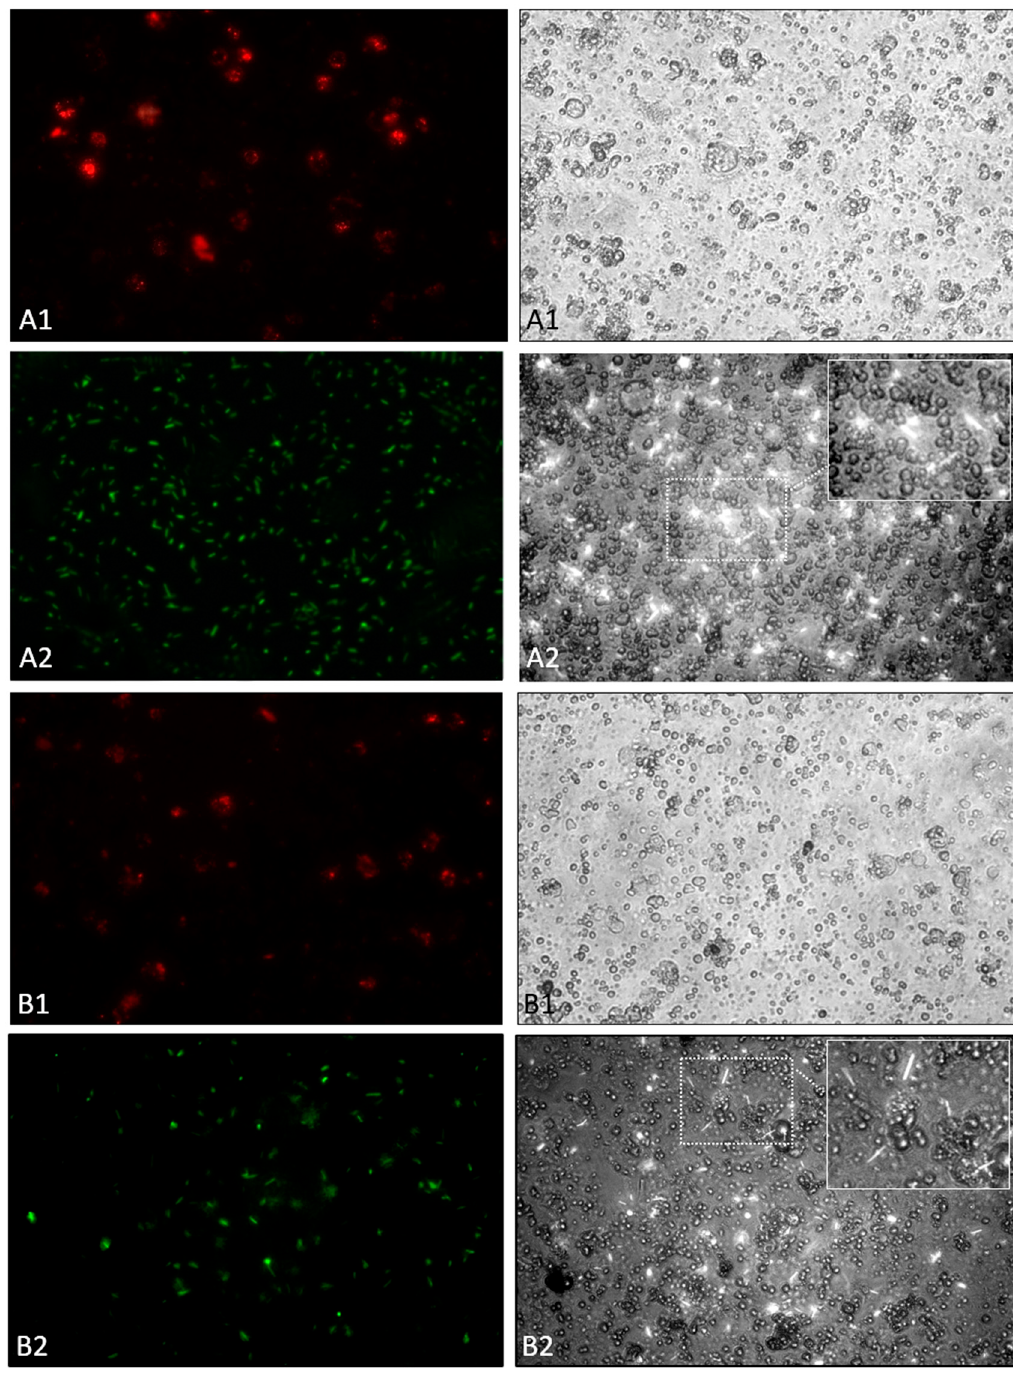
Figure 4. In vivo ( A ) and in vitro ( B ) phagocytic activity of D. suzukii larvae hemocytes against bacteria. A1: in vivo assay at 2 h with S. aureus- pHrodo TM BioParticles ® ; A2: in vivo assay at 2 h with X. nematophila -GFP, inside A2 right an enlargement of the central area of the image. B1: in vitro assay at 4 h with S. aureus- pHrodo TM BioParticles ® ; B2: in vitro assay at 4 h with X. nematophila- GFP, inside B2 right an enlargement of the central area of the image. All images on the right are bright field of the respective fluorescence micrographs on the left. Images magnification is 400×.